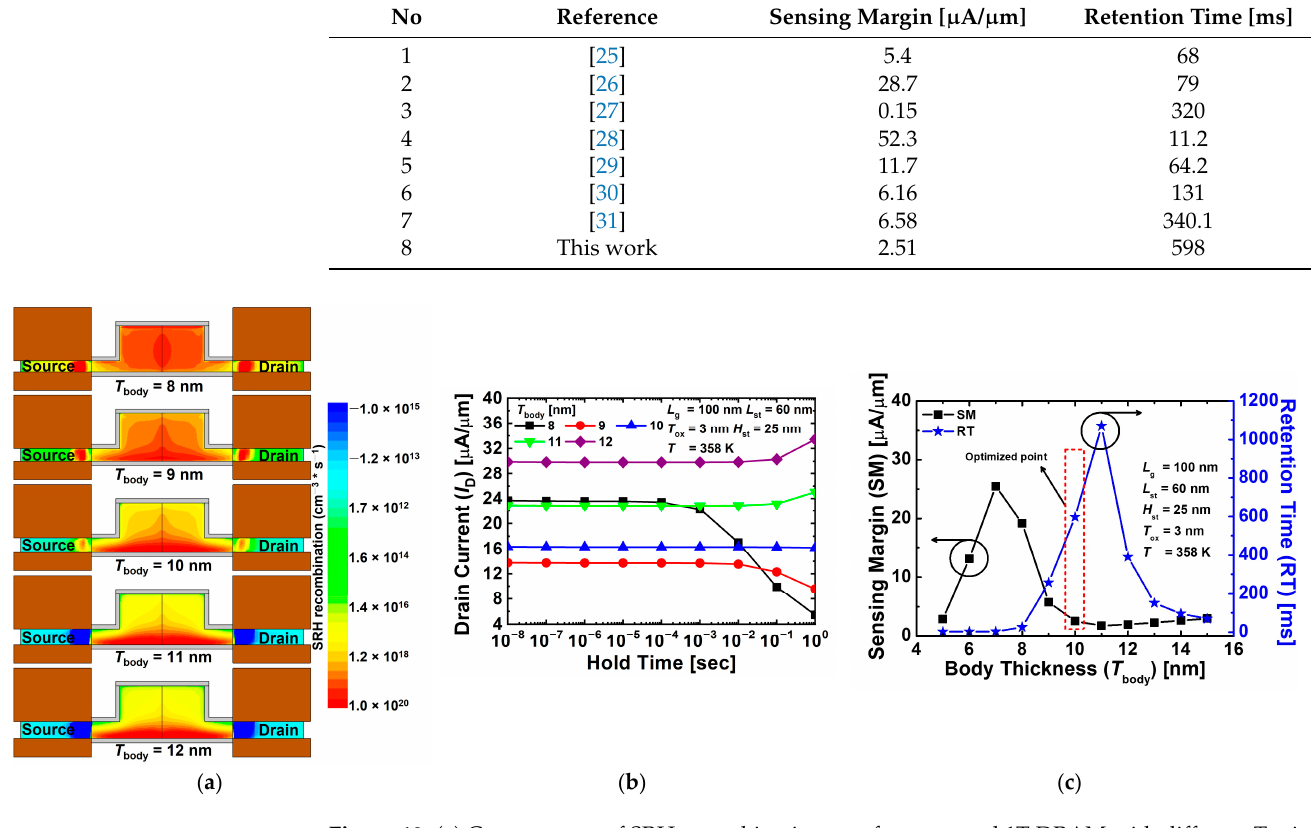
Figure 10. ( a ) Contour map of SRH recombination rate for proposed 1T-DRAM with different T ch in hold state “1” operation. ( b ) Read “1” current of proposed 1T-DRAM with different T ch . ( c ) Sensing margin and retention time of the proposed 1T-DRAM cell as a function of T ch . margin and retention time of the proposed 1T-DRAM cell as a function of T ch